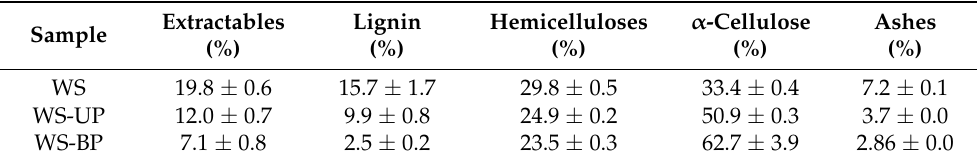
Table 1. Cellulose fiber characterization for wheat straw (WS), wheat straw unbleached pulp (WS-UP) and wheat straw bleached pulp